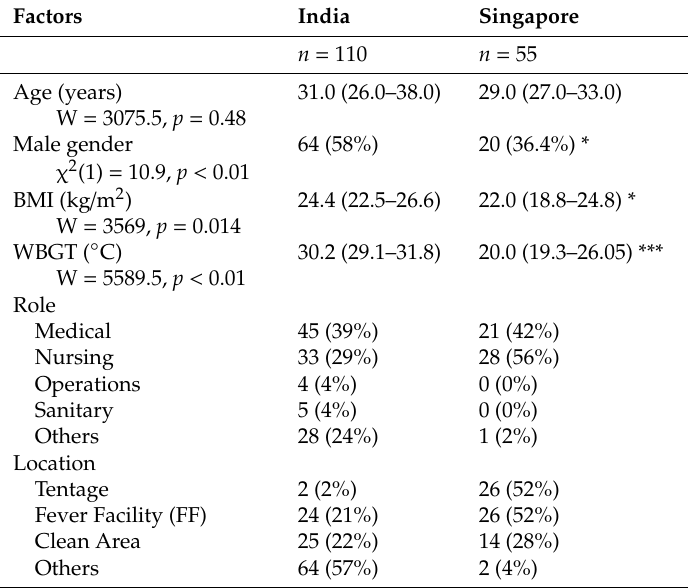
Table 1. Comparison of demographic details, roles, and location of workplaces among healthcare worker (HCW) respondents during the coronavirus disease 2019 (COVID-19) pandemic. (W = Wilcoxon rank-sum test statistics, χ 2 = Pearson chi-square test